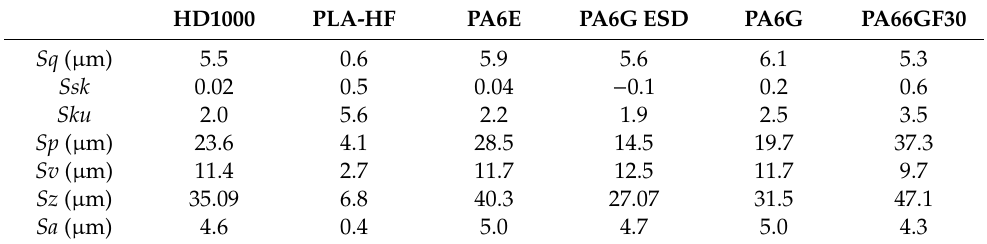
Figure 14. The tested polymer surfaces before testing: PLA-HF is pressed, while the others are machined surfaces. Table 10. 3D surface characteristics before